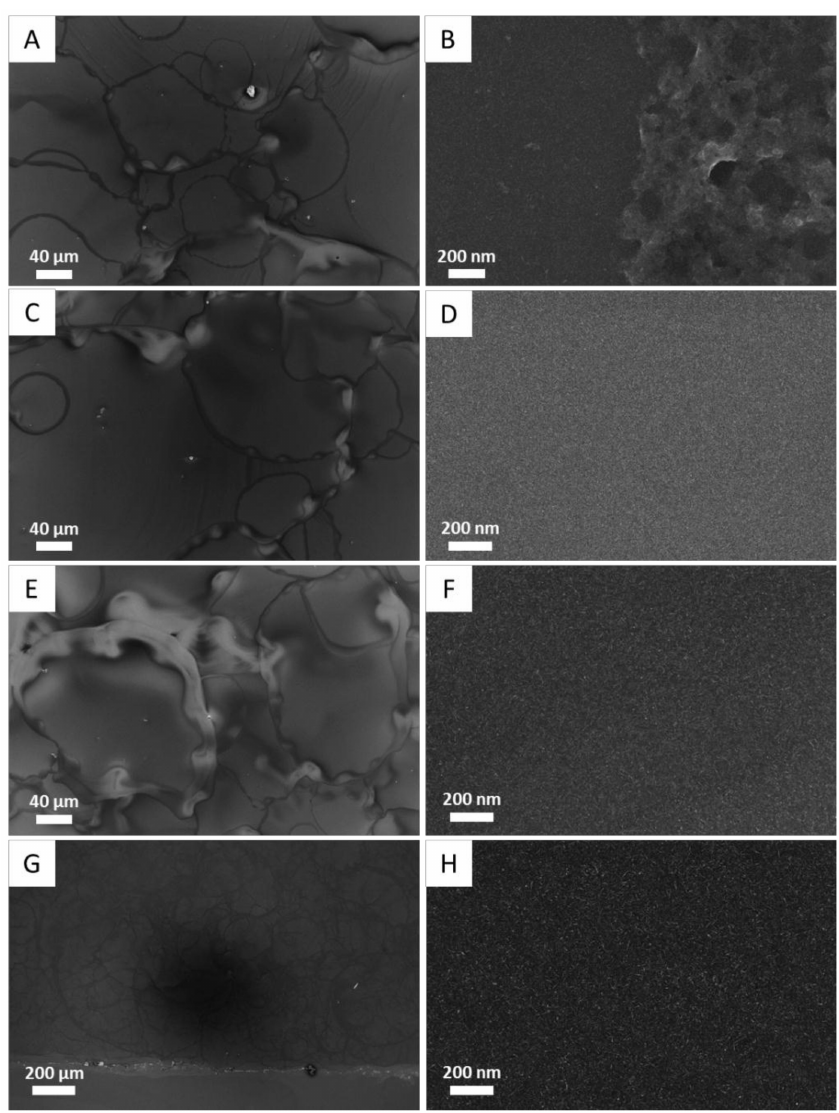
Figure 5. The SEM micrographs of TiO 2 NRs deposited by spray coating on silicon substrates from an n-heptane solution of 0.02 M. The micrographs are low magnification (left column) and high magnification images (right column) respectively of coatings obtained with an application time of 1 min (A-he A and B ), 1 min 30 s (B-he C and D ), 2 min (C-he E and F ), 2 min 30 s (D-he G and H ). The measurements were performed with an accelerating voltage of 5 kV, a working distance of 1.4 mm and an aperture size of 20 µ